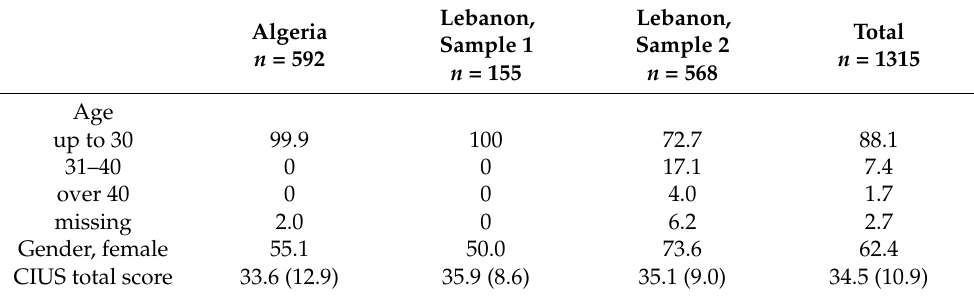
Table 1. Characteristics of the participants by country measured as mean (SD) for continuous variables and as percentage (%) for categorical variables. Algeria n =